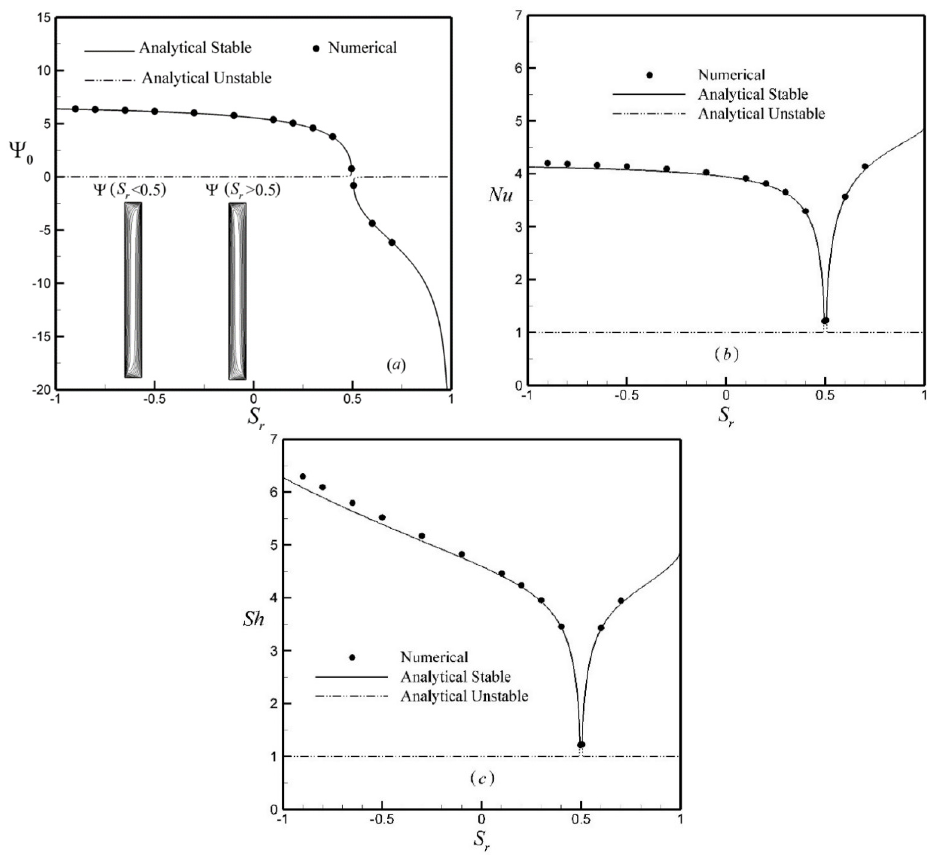
Figure 11. Effect of Soret parameter, S r , on ( a ) stream function at the center of the cavity, Ψ 0 , ( b ) local Nusselt number, N u , and ( c ) local Sherwood number, S h , for Da e = 10 − 4 , R T = 10 3 , Le = 2, ξ = 0, ε = 1 and D u = 0.